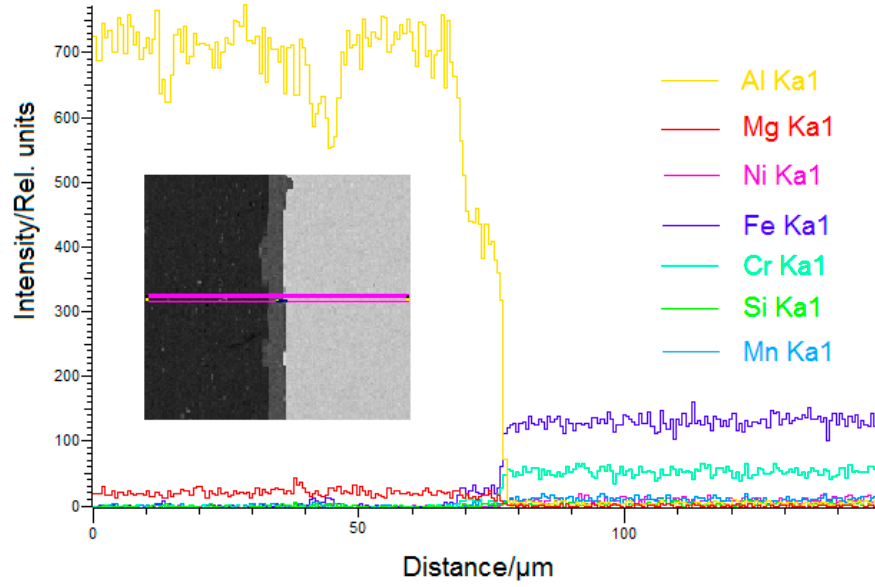
Figure 10. Energy-dispersive X-ray spectroscopy (EDS) results.